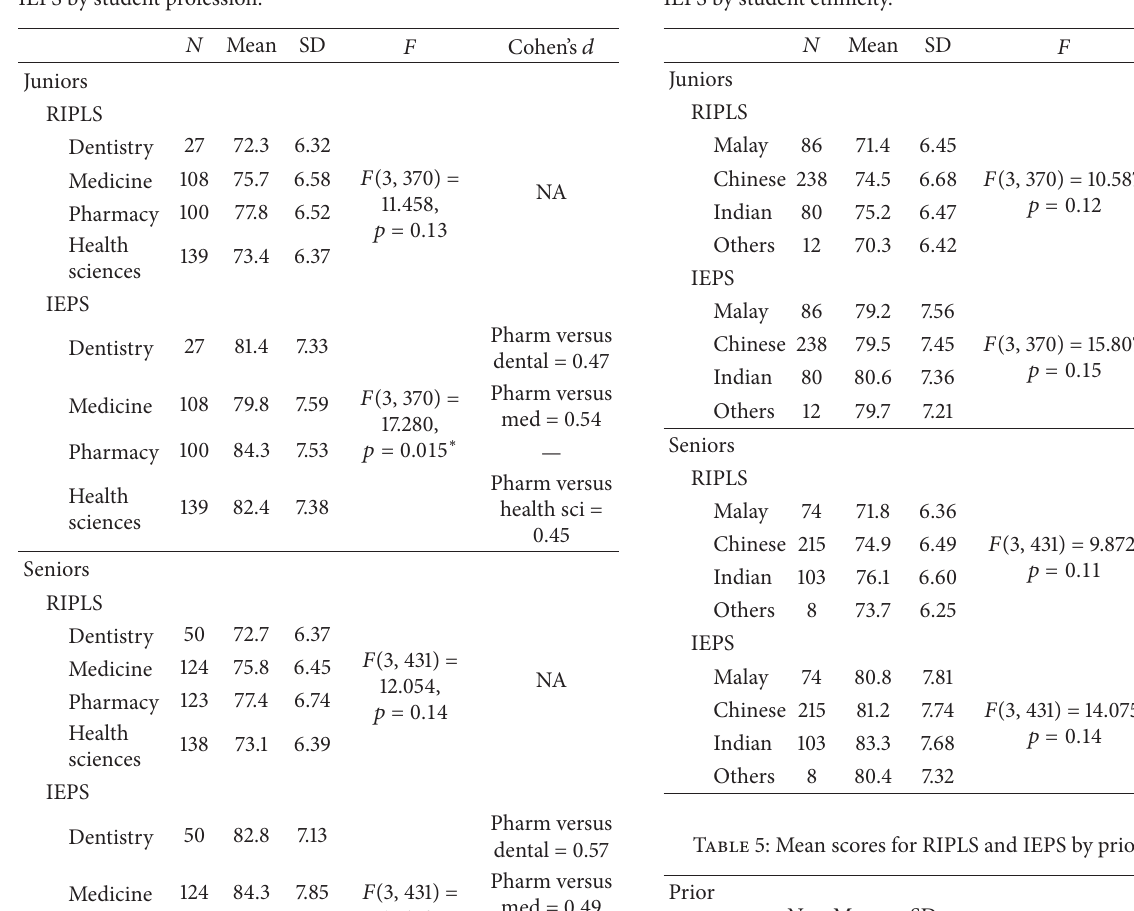
Table 3: Mean scores and significant differences of the RIPLS and IEPS by student profession.